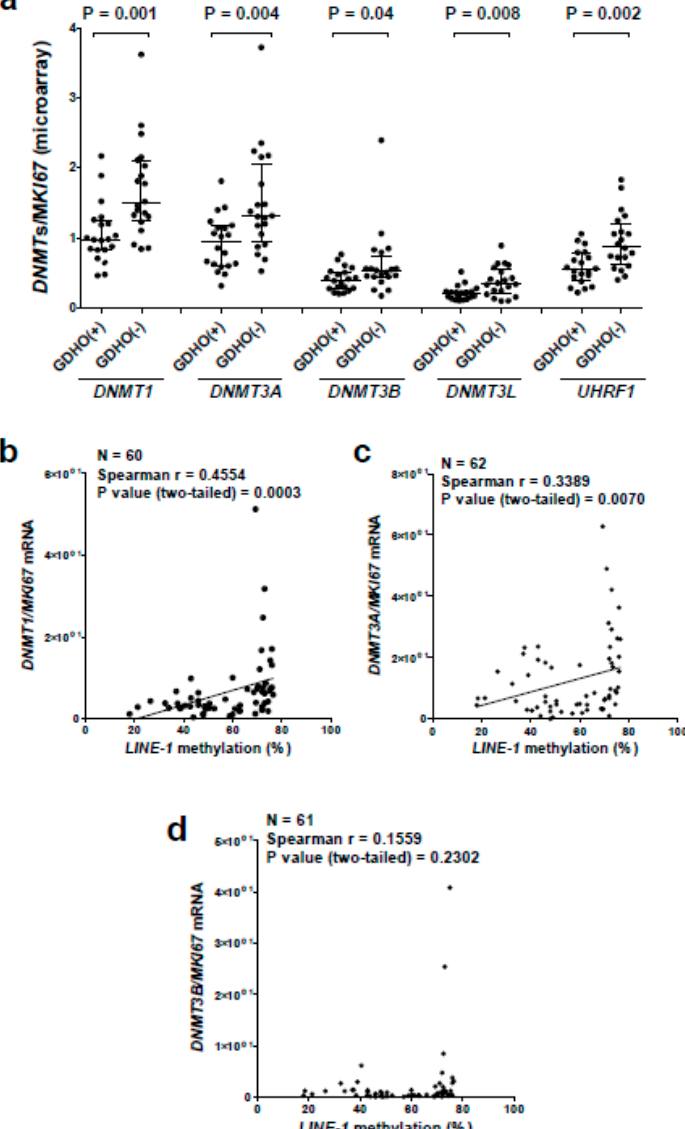
Figure 7. GDHO (+) EOC tumors show reduced expression of DNMTs and UHRF1 after normalization to proliferation. ( a ) Affymetrix gene expression data for DNMT1 , DNMT3A , DNMT3B , DNMT3L , and UHRF1 , normalized to MKI67 , in GDHO (+) and GDHO ( − ) EOC. Median with interquartile range is plotted, and Mann–Whitney test p-values are shown. ( b – d ) Gene expression of ( b ) DNMT1 , ( c ) DNMT3A , and ( d ) DNMT3B , normalized to MKI67 , in EOC, as compared to LINE-1 methylation in matched samples. Gene expression data were obtained by RT-qPCR, and LINE-1 methylation was determined by bisulfite pyrosequencing. Spearman correlation analysis test results are